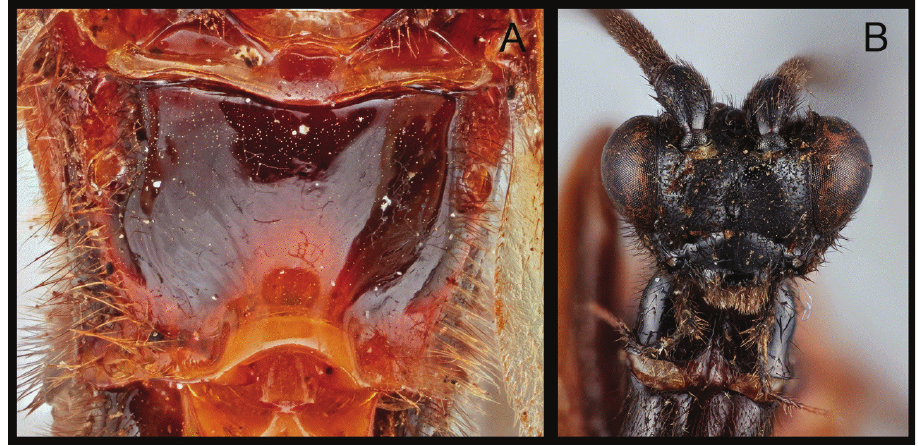
Figure 7. Heteropteron sp. A Dorsal propodeum B anterior